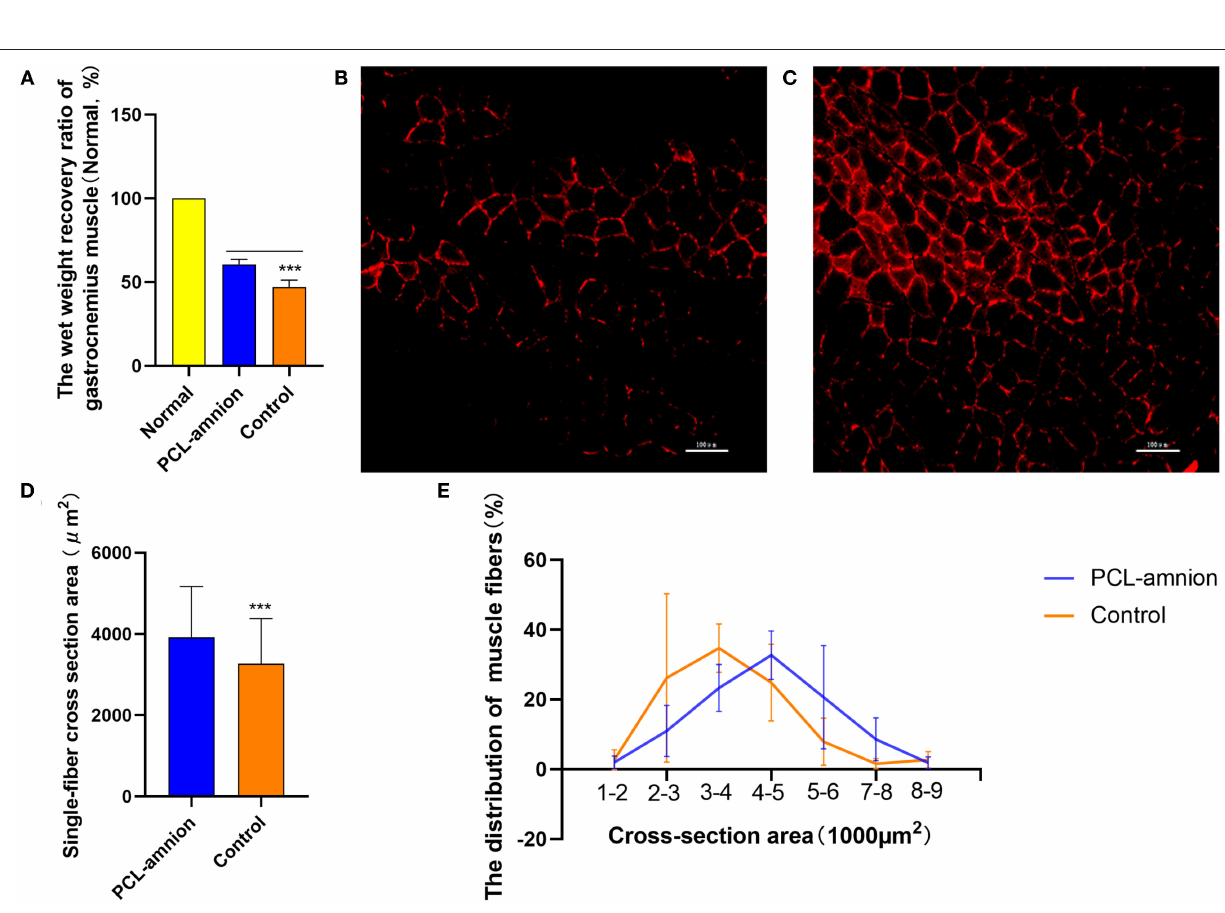
Frontiers in Surgery |